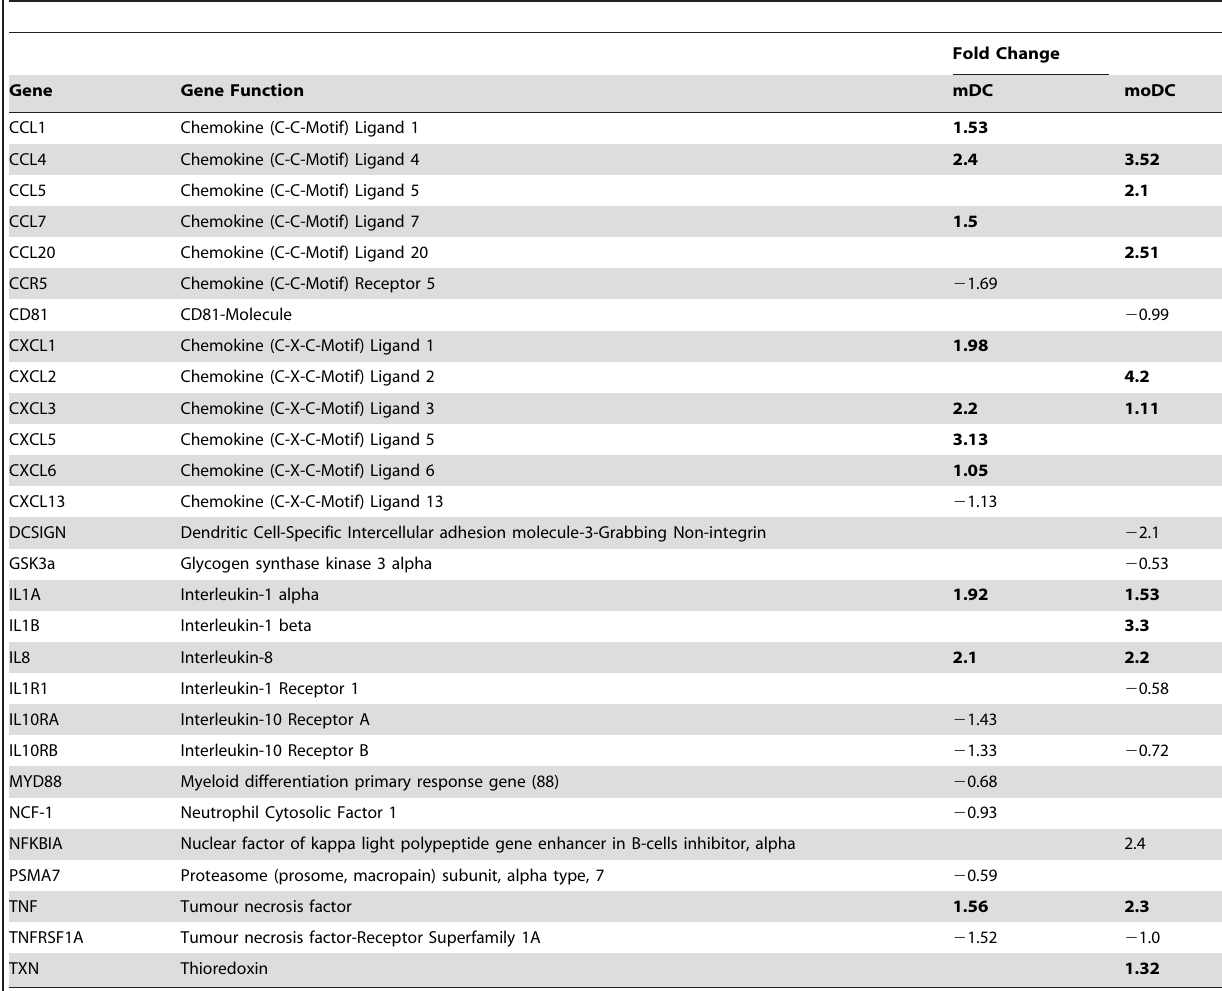
Table 4. Gene expression of immune-related genes in donor myeloid dendritic cells or monocyte-derived dendritic cells induced by the addition of A. fumigatus germ tubes (after 6 hours